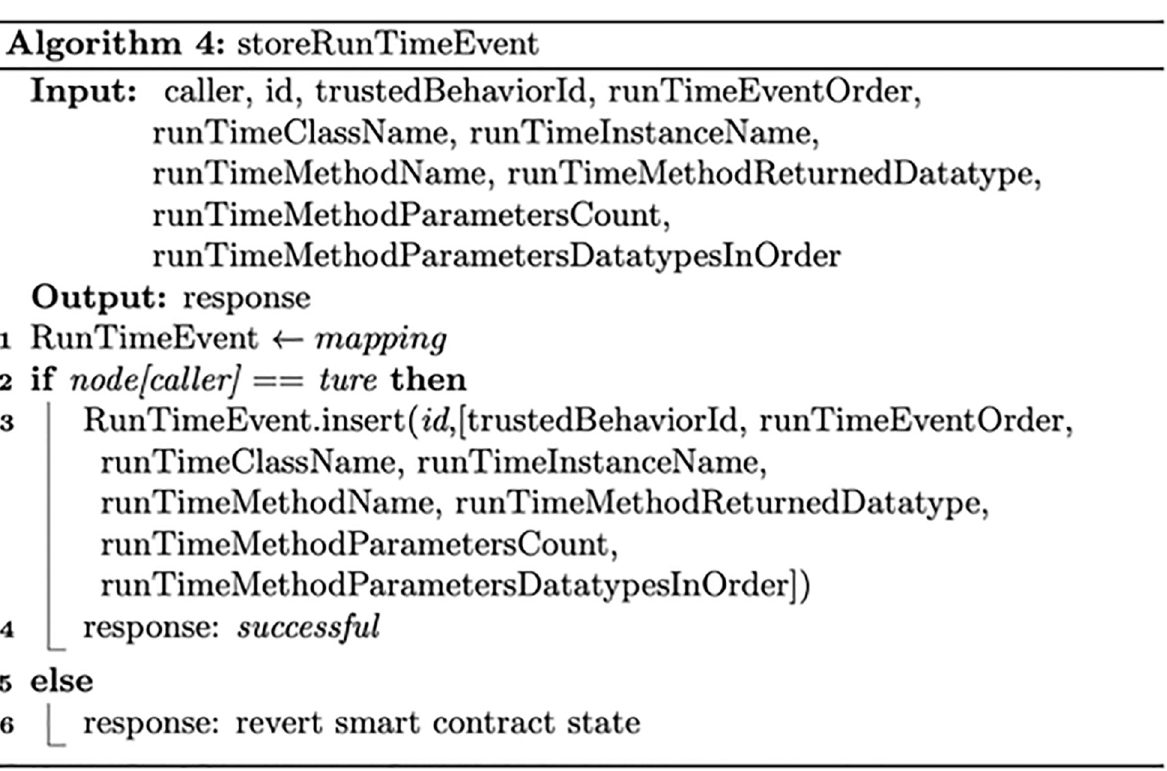
Fig 5. The process of storing and managing run-time software